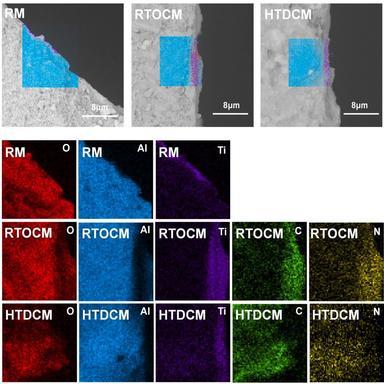
EDAX elemental mapping images of RM, RTOCM, and HTDCM.